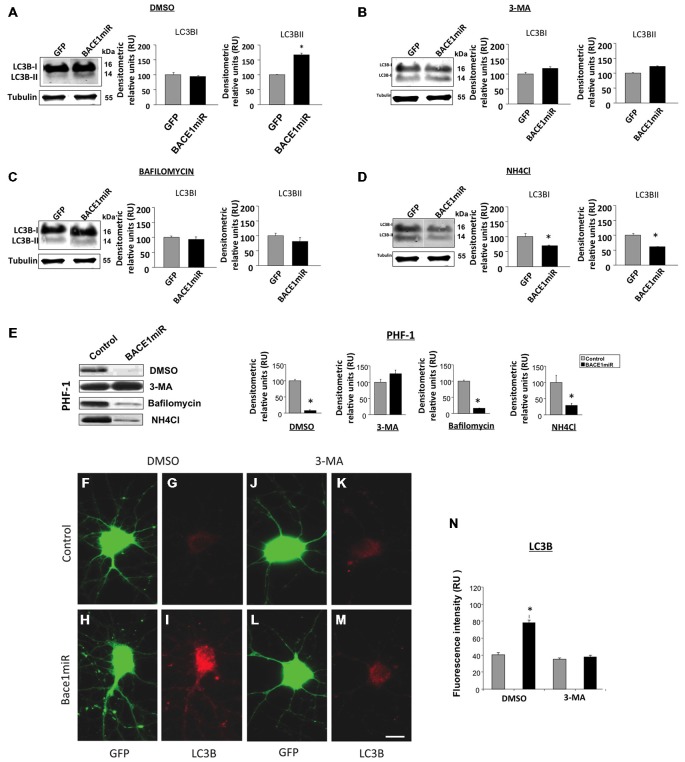
BACE1miR reduces the level of hyperphosphorylated tau, and this effect is blocked by 3-MA. Primary cortical cultures were transduced with AAV2/5-BACE1miR or AAV2/5-GFP at DIV5 for 7 days. The neurons were exposed to autophagy inhibitors, including 3-methyladenine (10 mM), bafilomycin (100 nM), ammonium chloride (NH4Cl, 20 mM) or DMSO for 24 h. (A) Representative bands and quantification of the levels of LC-3B I and II proteins from neurons transduced with AAV2/5-BACE1miR or AAV2/5-GFP and treated with DMSO, (B) 3-methyladenine (10 mM), (C) bafilomycin (100 nM), and (D) ammonium chloride (NH4Cl, 20 mM). RU = relative units, n = 3, *p < 0.05. (E) Representative Western blots for PHF-1 from neurons transduced with AAV2/5-GFP or AAV2/5-BACE1miR. βIII-tubulin was used as a loading control. Densitometric quantification was performed; RU = relative units. n = 3, *p < 0.05. (F,J) GFP expression in hippocampal neurons transduced with AAV2/5-GFP (control). (H,L) GFP expression in hippocampal neurons transduced with AAV2/5-BACE1miR (BACE1miR). (G,K) LC3B immunofluorescence in neurons transduced with AAV2/5-GFP (control). (I,M) LC3B immunofluorescence in neurons transduced with AAV2/5-BACE1miR (BACE1miR). (F–I) Neurons were treated with DMSO as a control; (J–M) neurons were treated with 3-methyladenine (10 mM). Green: GFP fluorescence, red: Alexa 594 fluorescence. 60X magnification; scale bar: 20 μm. n = 3. (N) Quantification of the LC3B fluorescence intensity using Scope-Pro image software (Media Cybernetics) in neurons transduced with AAV2/5-BACE1miR or AAV2/5-GFP and treated with 3-methyladenine (10 mM) or DMSO; RU = relative units, n = 3, *p < 0.05.